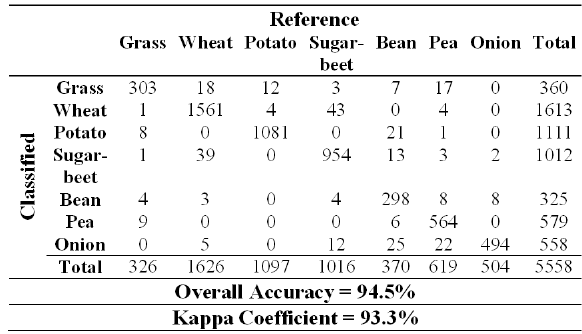
Table 1. Accuracy assessment of SVM